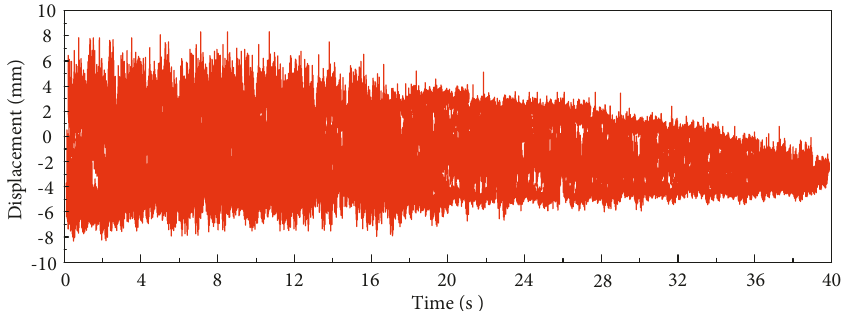
Figure 10: Vibration displacement response diagram of observation point 8.